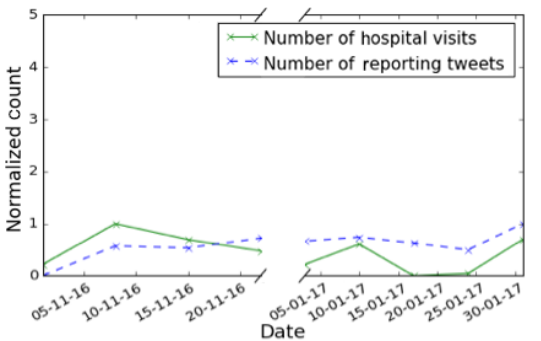
Fig. 10 Count of Arabic tweets (classified as self and nonself) versus count of actual hospital visits.